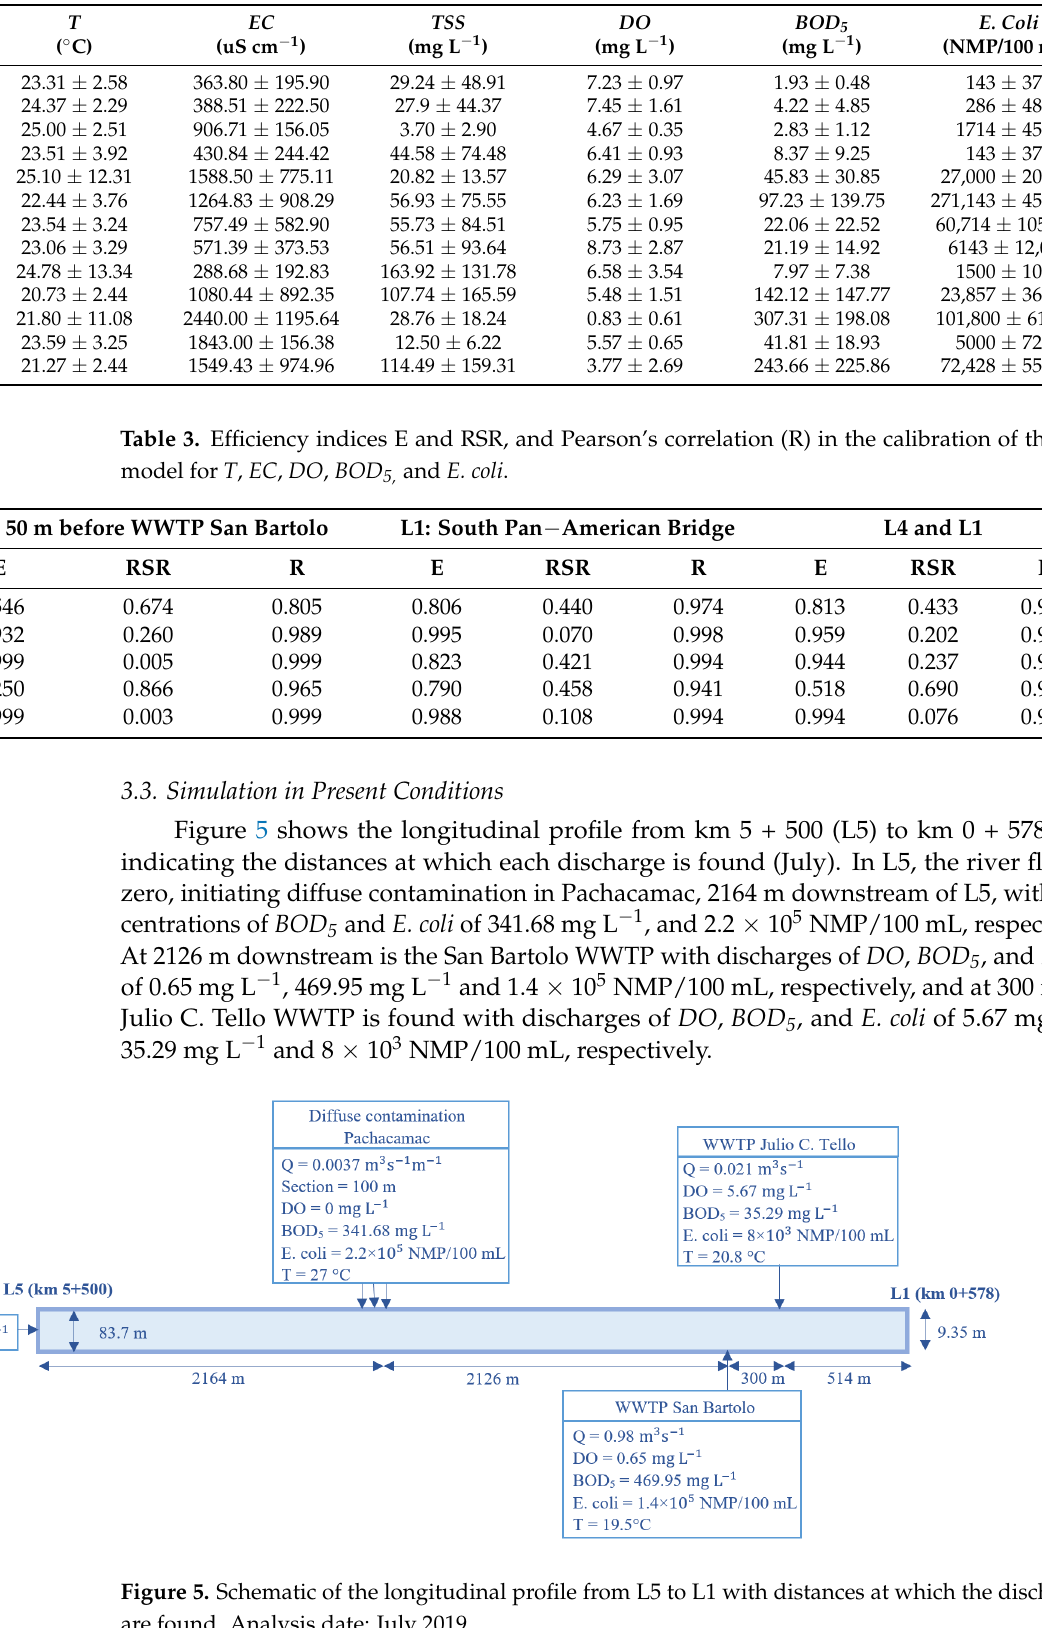
Table 2. Means and standard deviation ( x ± S) for water quality from data obtained in evaluations completed between February and August 2019.